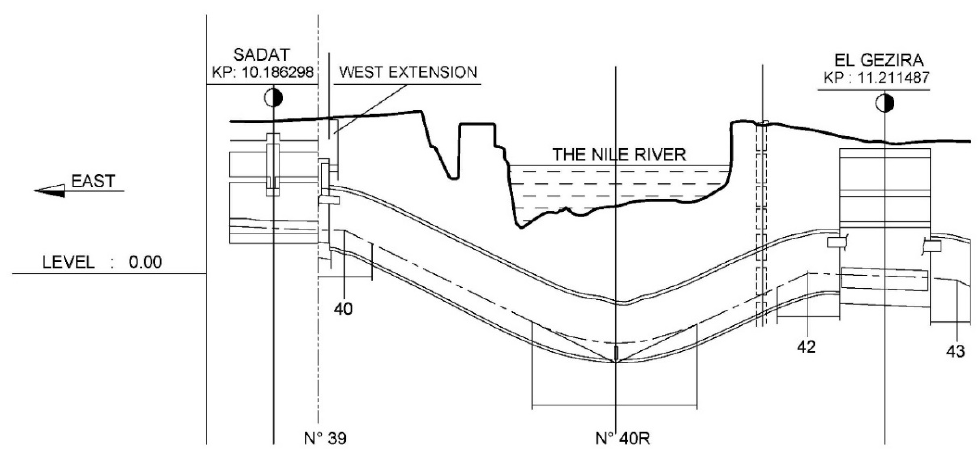
Figure 1. Tunnel layout under the east branch of the Nile River.